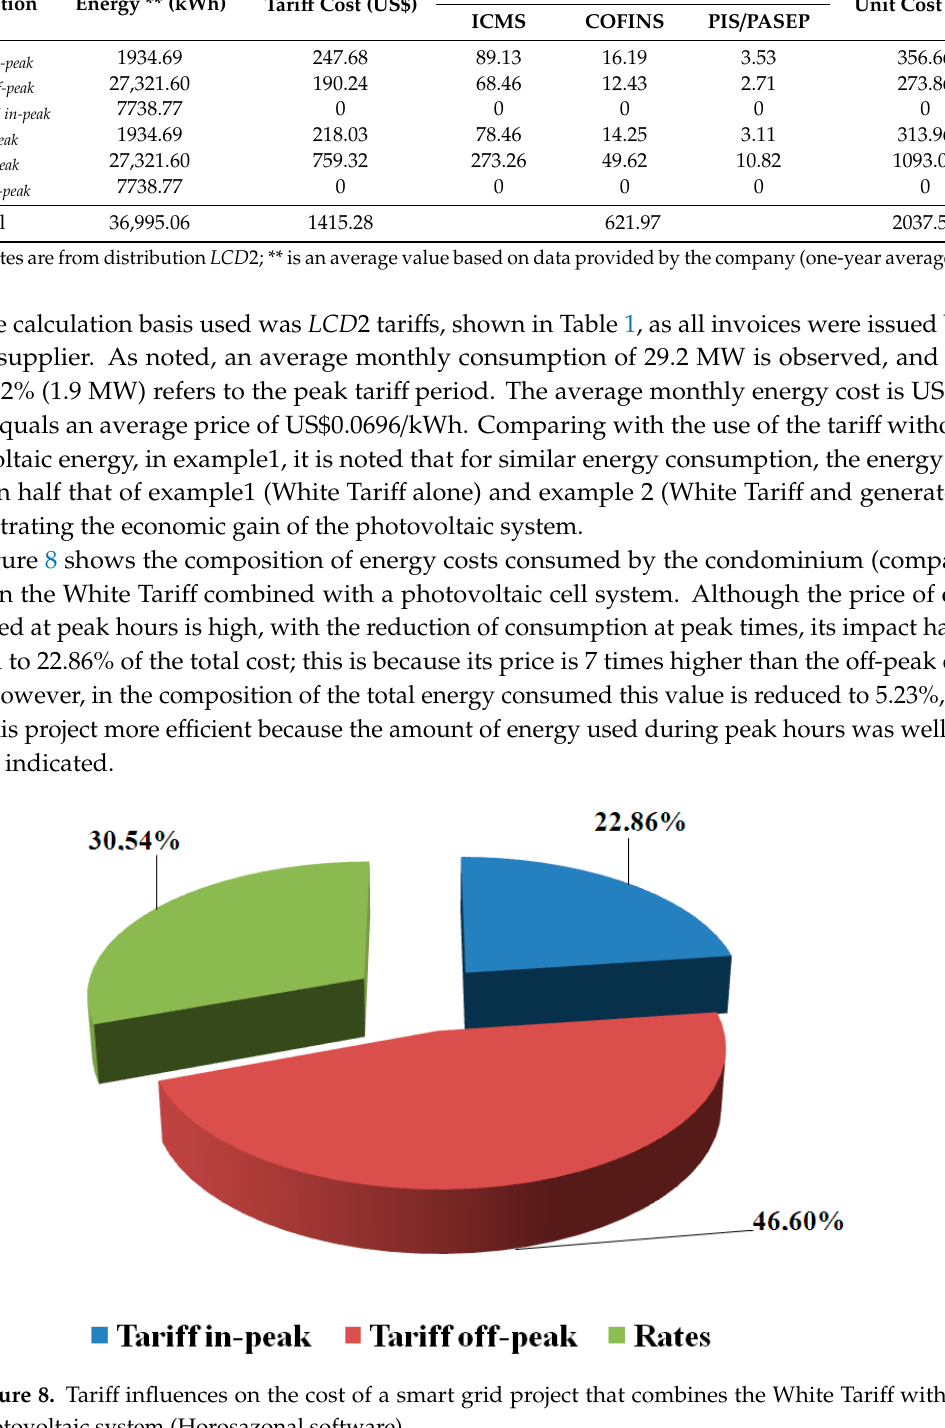
Table 10. E nergy costs according to the conventional tariff for company B.